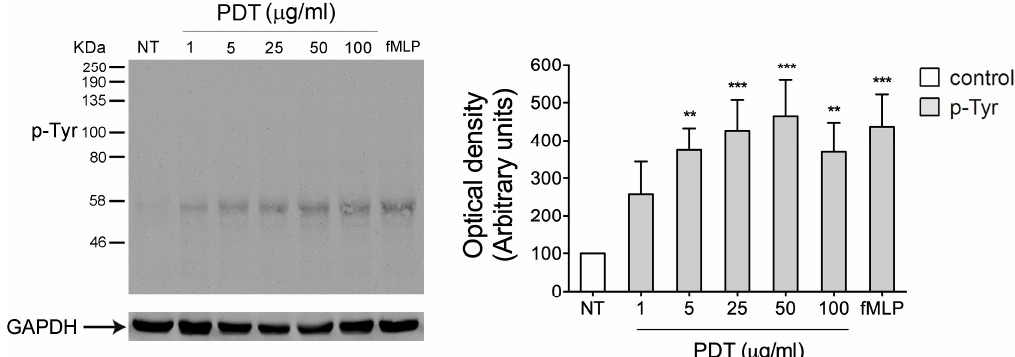
Figure 1. Effect of PDT stimulation on protein tyrosine phosphorylation in monocytes. Monocytes were treated for 5 min with 1, 5, 25, 50, 100 μ g/mL of PDT and 10 nM of fMLP. Untreated cells were used as control (NT). Western blot analysis of cells lysates shows that PDT is able to induce an increase of Tyr phosphorylated proteins at different concentrations tested, as shown by densitometry analysis and plotting of the pTyr/GAPDH. In the left panel blots from one representative experiment of three with similar results are shown. In the right panels, values reported for protein Tyr phosphorylation are the mean ± SD of three independent experiments. Statistical analysis was performed by one-way ANOVA and the Bonferroni’s post-test was used to compare data, ** p < 0.01, *** p < 0.001.